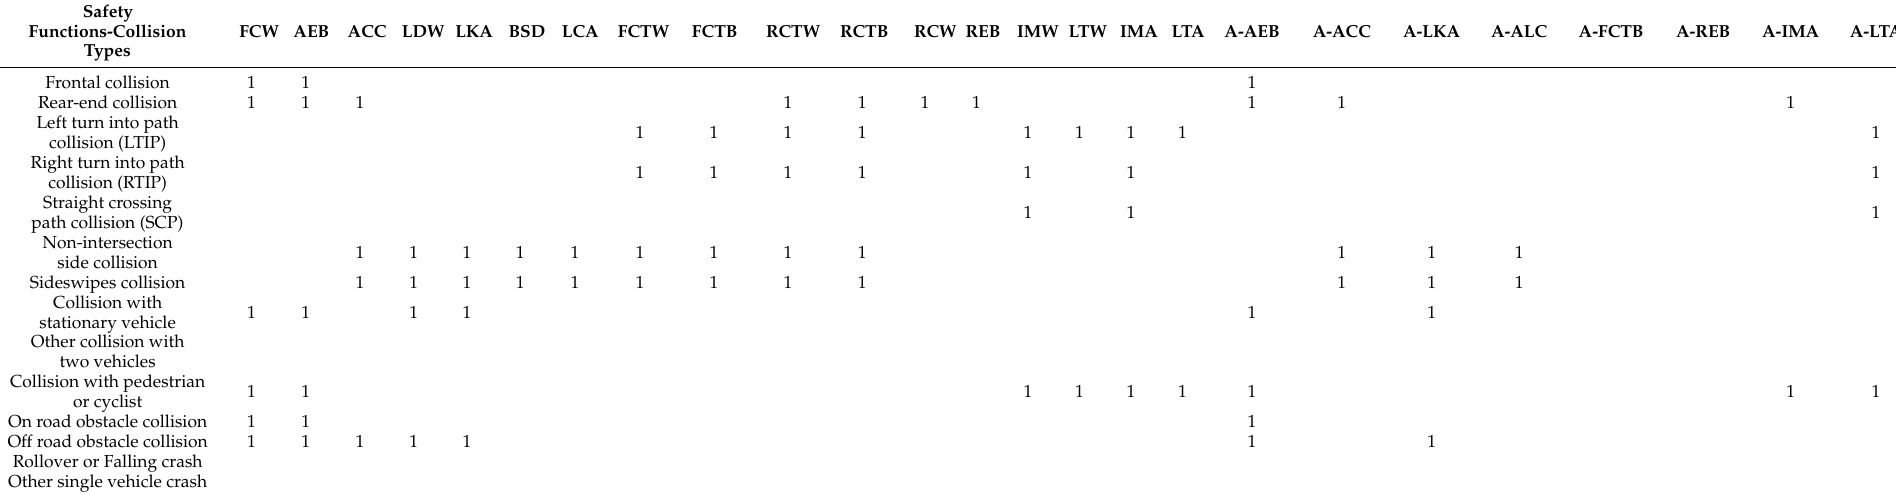
Table 3. Target accident matrix of safety